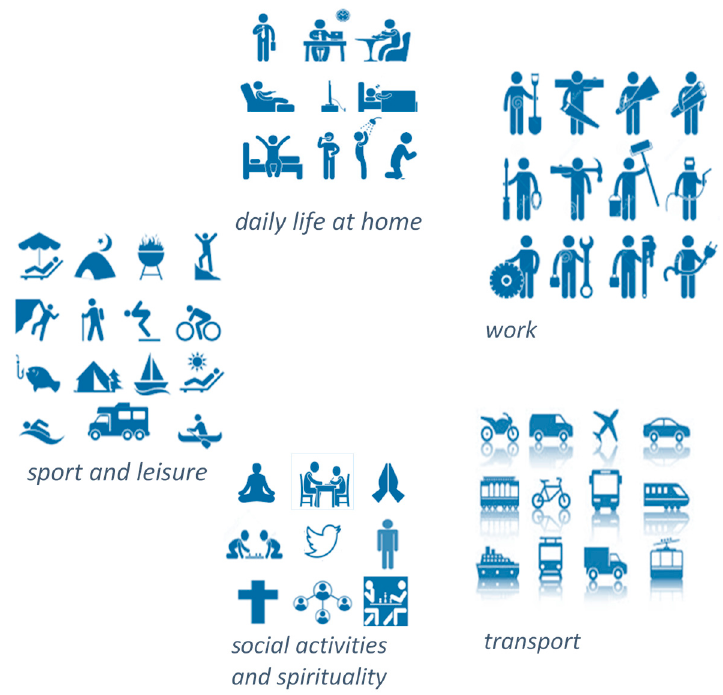
Figure 2. The five user practices; (1) daily life at home, (2) work, (3) transport, (4) social activities and spirituality, and (5) sport and leisure.